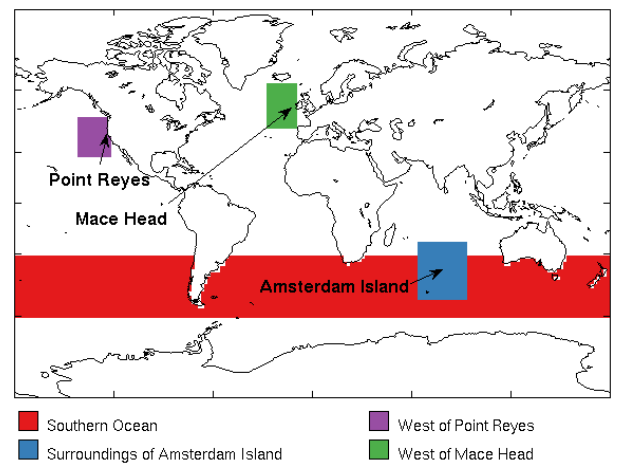
Figure 1. The locations of the three in situ measurement stations, and ocean masks used for aerosol optical depth